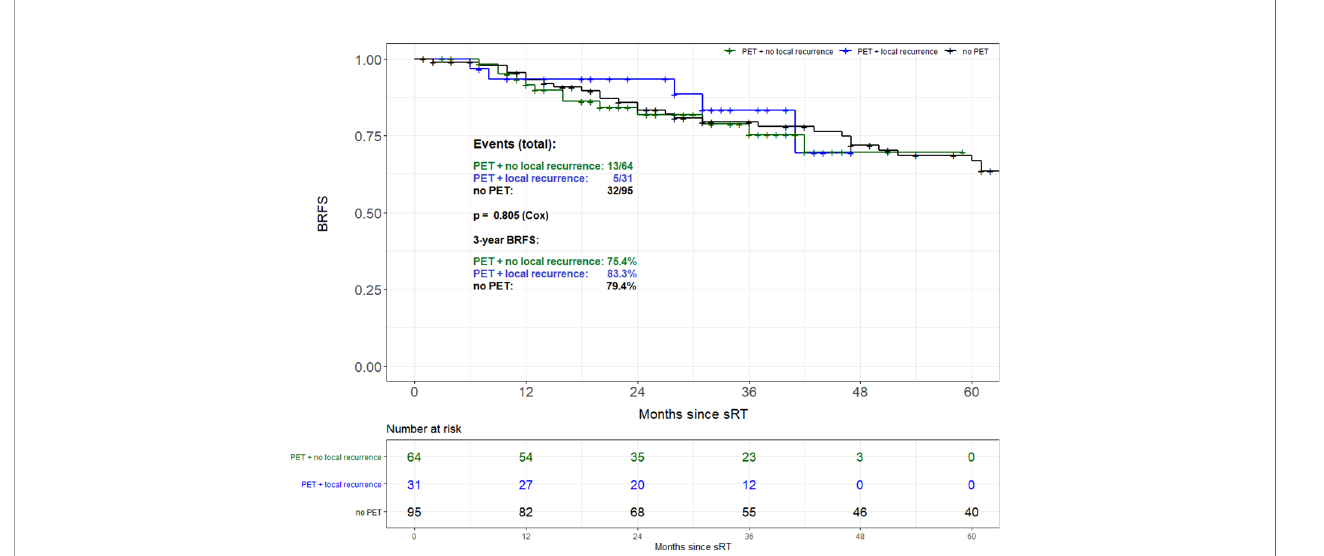
FIGURE 3 | Biochemical recurrence-free survival of patients with PET-positive local recurrence vs. patients without PET/CT.